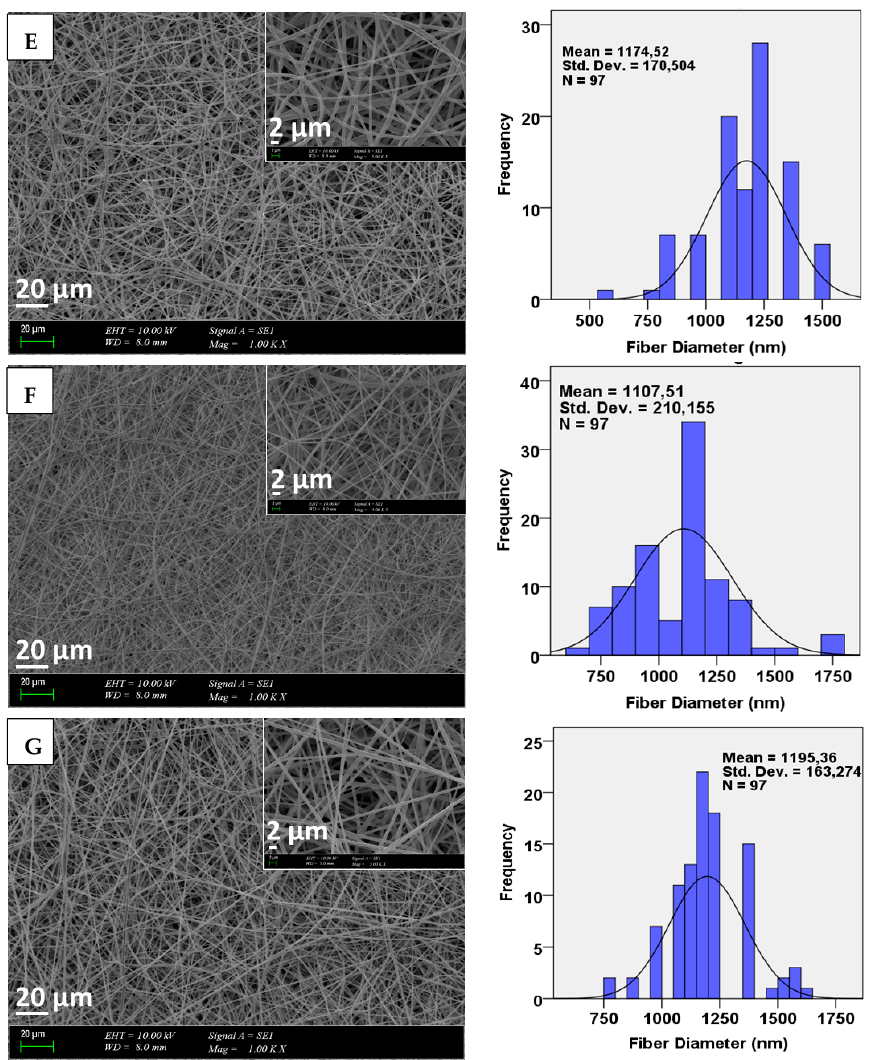
Figure 2. SEM images of the 10%PLA ( A ), 10%PLA/0.1%GO ( B ), 10%PLA/0.5%GO ( C ), 10%PLA/1% GO ( D ) 10%PLA/0.1%GO/Q ( E ), 10%PLA/0.5%GO/Q ( F ), 10%PLA/1%GO/Q ( G ) and their diameter distributions.